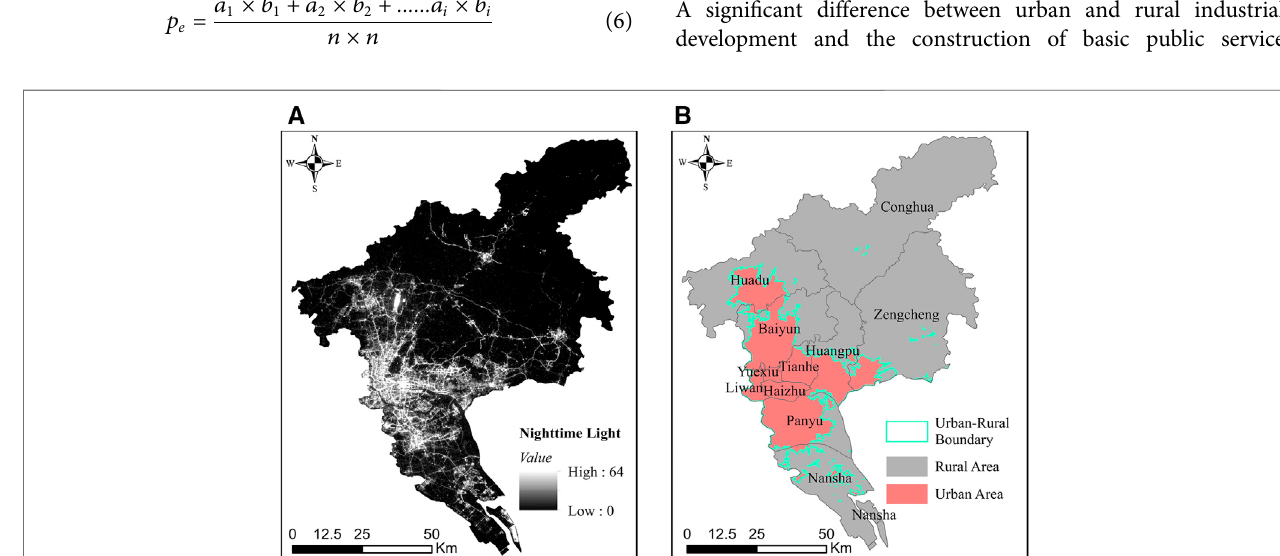
FIGURE4|(A) Spatial Distribution ofNTL Data; (B) Urban and RuralAreasIdenti fi ed byNTLData(The urban and ruralspatial areaidenti fi ed byNTLdataisshown in the fi gure, among which, (A) is NTL data and (B) is the identi fi ed urban and rural spatial area).